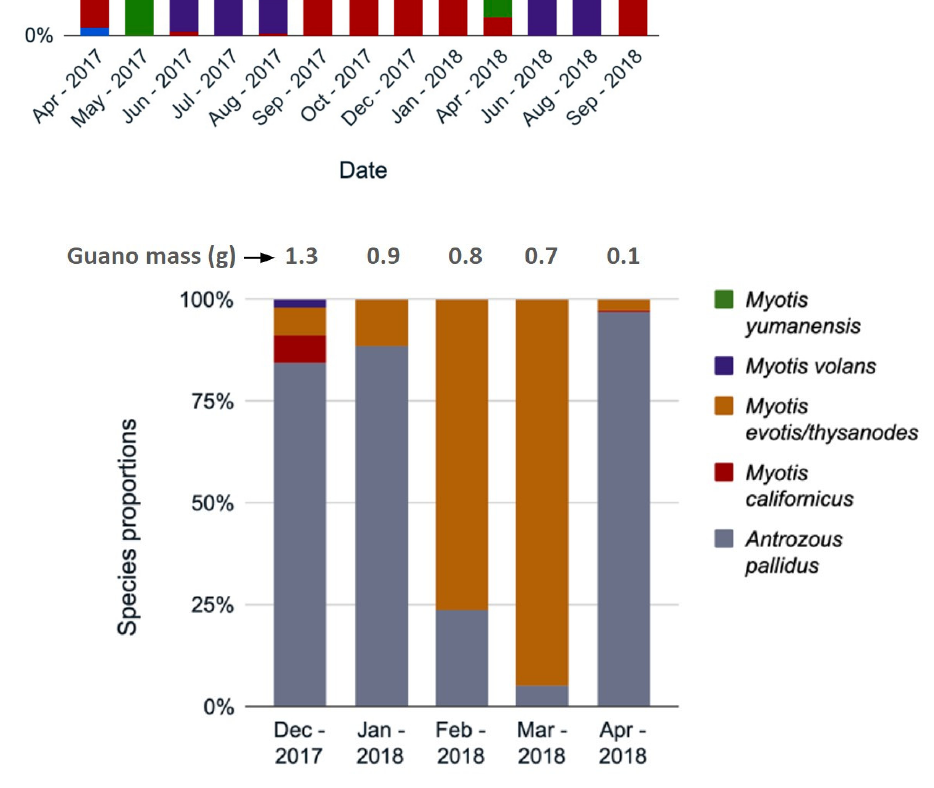
Figure 5. Species identifications by percentage of monthly guano collections at hollows ( a ) Grizzly Creek 22, and ( b ) Mailliard Redwoods 01, California. Some months are missing due to unsuccessful amplification of DNA.